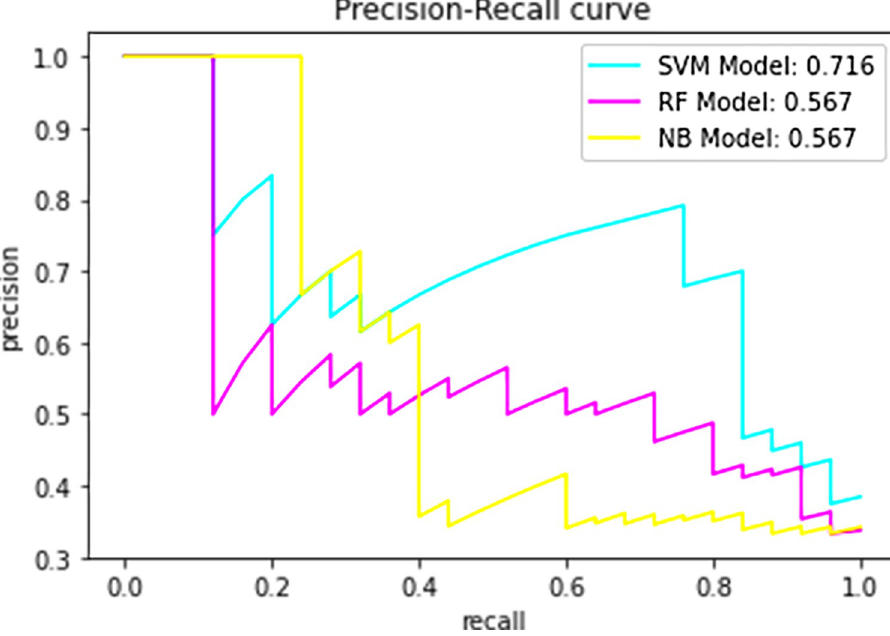
Fig 7. Precision-recall curves of the three candidate models for the prognosis of IgAN without ’Crescent proportion’ and ’Global crescent proportion’.